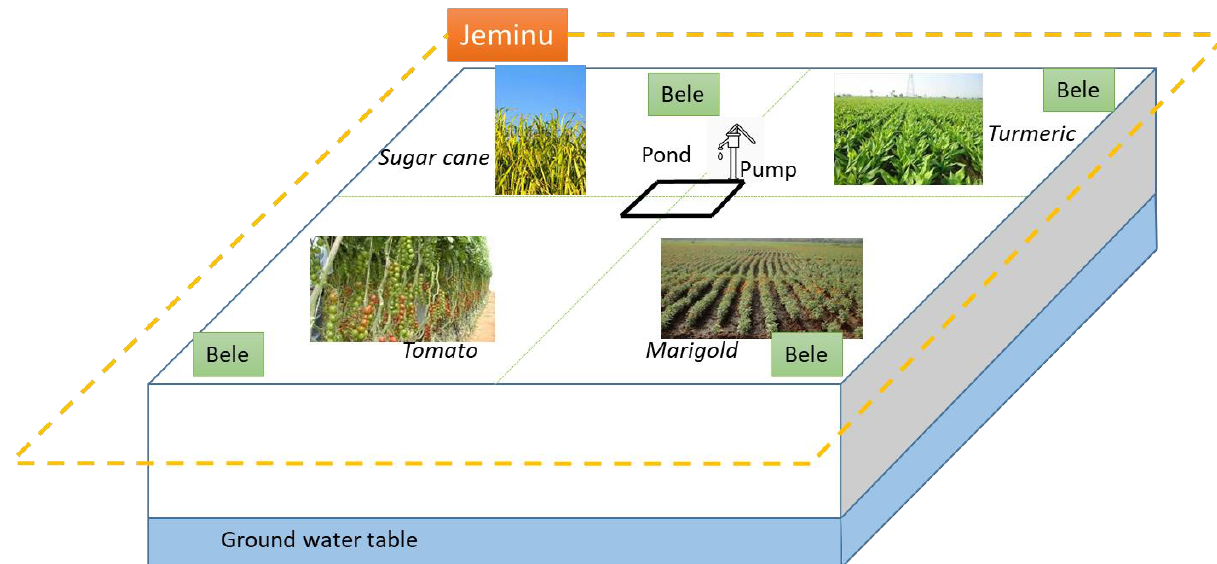
Figure 1. Schematic representation of a jeminu.